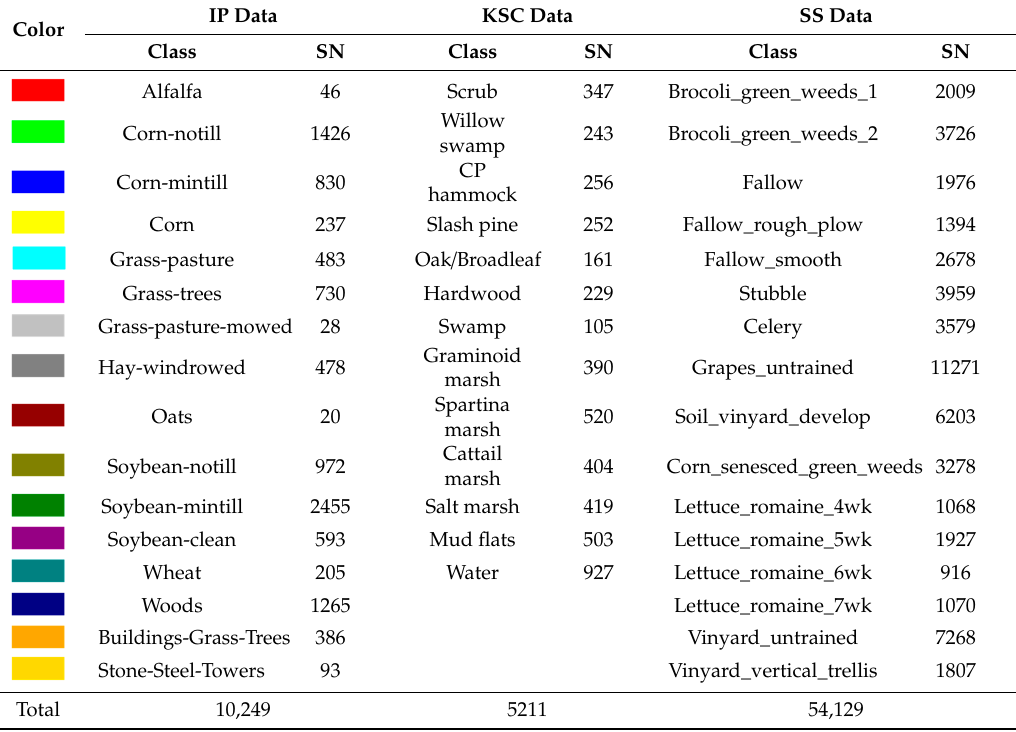
Table 2. Color codes for the classes, class types, and sample numbers (SN) for the ground truths of the Indiana Pines (IP) data, Kennedy Space Center (KSC) data, and Salinas Scene (SS) data.